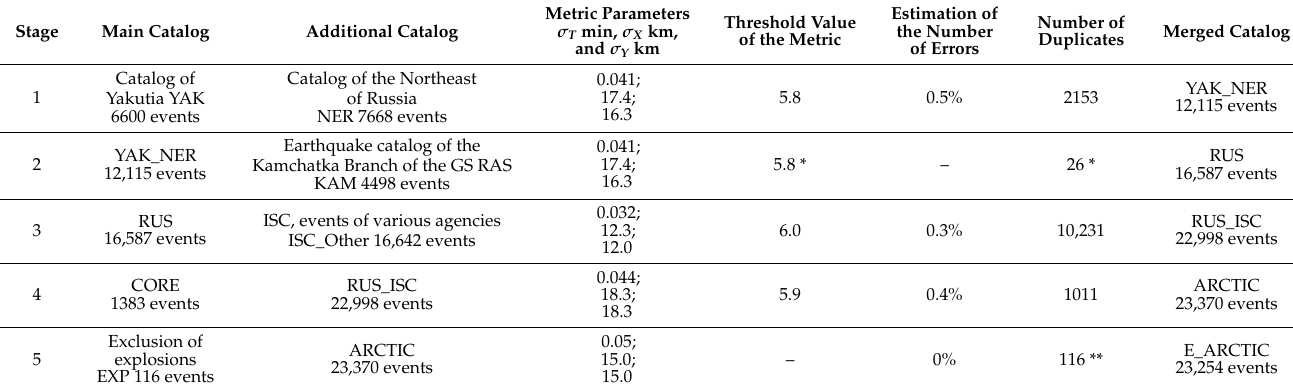
Table 3. Scheme and compilation parameters of the integrated